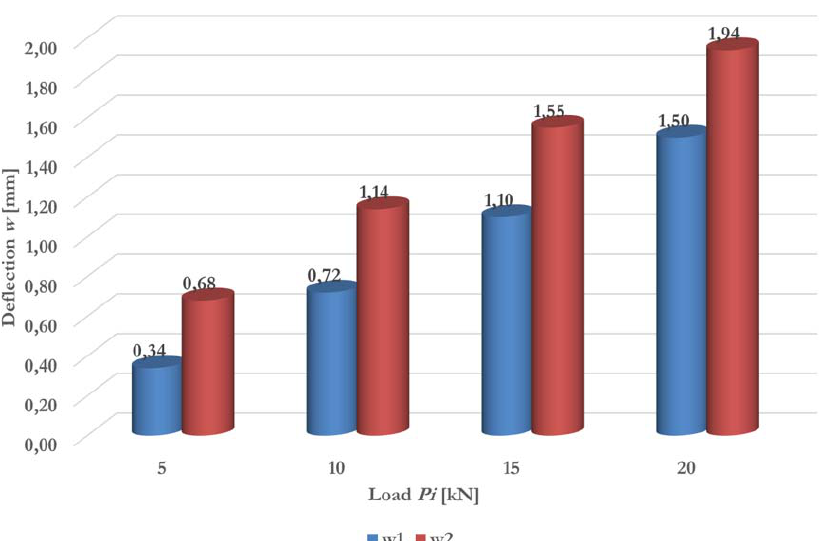
Figure 12: Results of measurements of deflection in the center of the slab, at various loads with concentrated force Pi in the geometric center of the slab, normal to its surface, where: 1 w – the load was applied from the side of the titanium layer, 2 w – the load was applied from the side of the steel